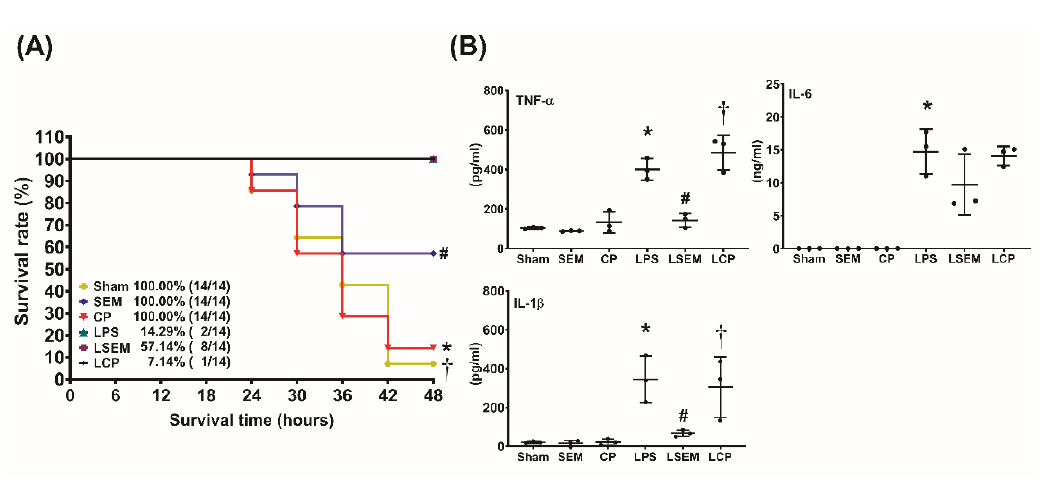
Figure 2. SEM18 peptide increases survival and decreases systemic inflammatory responses in endotoxin-treated mice. ( A ) The 48 h survival rate, as measured at 48 h after lipopolysaccharide (LPS) or normal saline (NS) administration. ( B ) Plasma concentrations of tumor necrosis factor (TNF)-α, interleukin-1β (IL-1β), and IL-6, as measured at 24 h after LPS or NS administration using enzyme-linked immunosorbent assay (ELISA). Sham: the NS group; SEM: the NS plus SEM18 peptide group. CP: the NS plus control peptide (CP) group; LPS: the LPS (15 mg/kg) group; LSEM: the LPS (15 mg/kg) plus SEM18 peptide group; LCP: the LPS (15 mg/kg) plus CP group. Data are presented as the mean ± standard deviation. Data of survival rates and ELISA were derived from 14 and three mice from each group, respectively. * p < 0.05, the LPS group vs. the sham group; # p < 0.05, the LSEM group vs. the LPS group; † p < 0.05, the LCP group vs. the LSEM group .